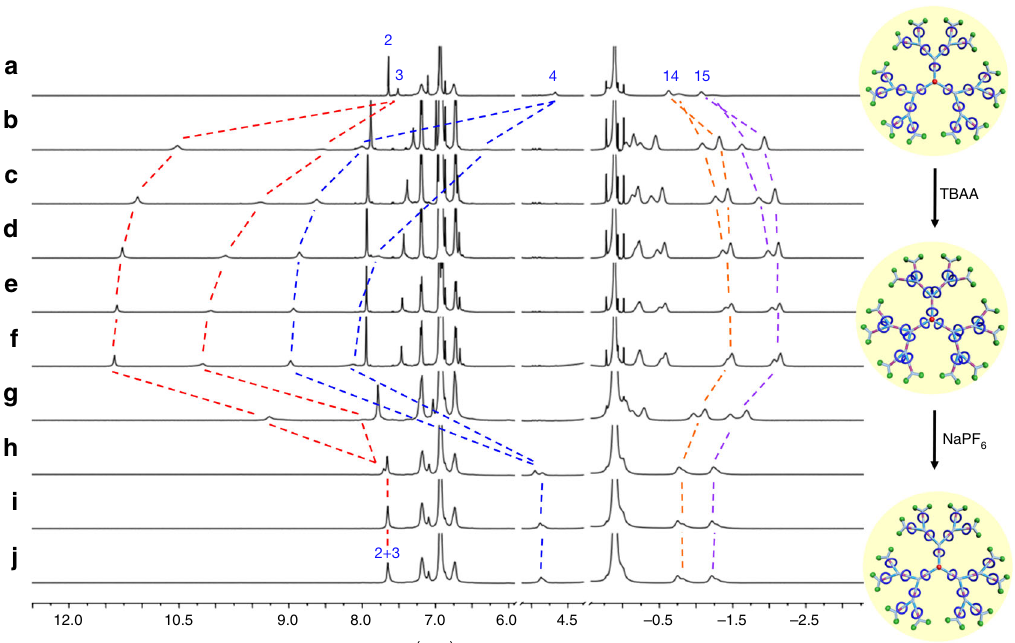
Fig. 6 1 H NMR spectra (THF- d 8 , 298 K, 500 MHz) of anion-induced switching motion of rotaxane-branched dendrimer G 3 . a G 3 ; the mixture of G 3 and TBAA, for each rotaxane unit: b TBAA (1 equiv); c TBAA (2 equiv); d TBAA (3 equiv); e TBAA (4 equiv); f TBAA (5 equiv); and the mixture obtained after adding NaPF 6 to the solution in f , for each rotaxane unit: g NaPF 6 (5 equiv); h NaPF 6 (7 equiv); i NaPF 6 (8 equiv); j NaPF 6 (10